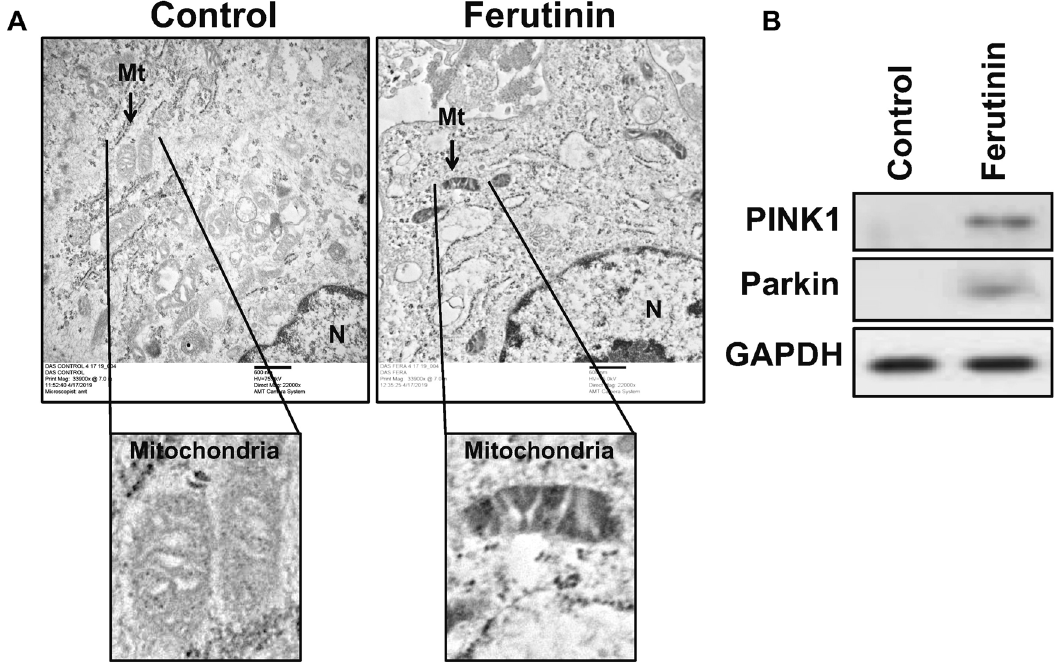
Fig. 6 Ferutinin distorts healthy mitochondrial structures towards mitophagy in DPSCs. A Ferutinin was added to the DPSCs, and after 24 h cells were subjected to transmission electron microscopic (BioTEM) analysis to detect mitochondrial ultrastructural morphology. Areas of speci fi c interest were blown to show mitochondrial ultrastructure. B Similarly, ferutinin was added to the DPSCs. After 24 h cells were harvested and collected total proteins were subjected to western blot analysis for mitophagy marker molecules, and the GAPDH was considered as an internal control ( n =